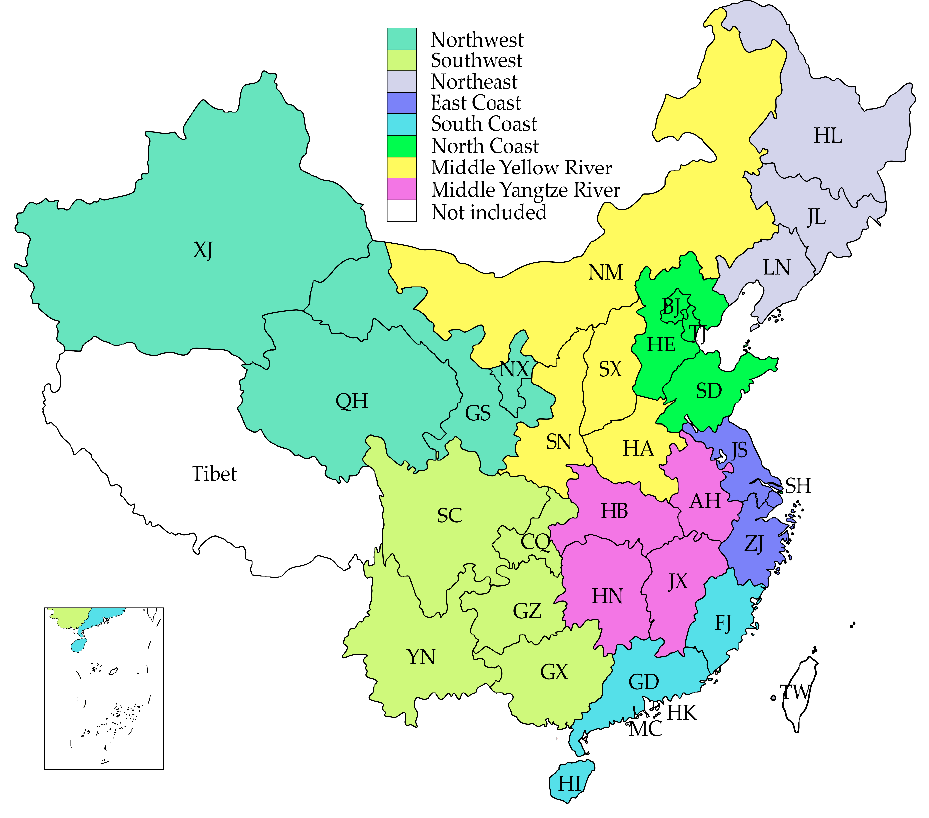
Figure 1. The eight regions in